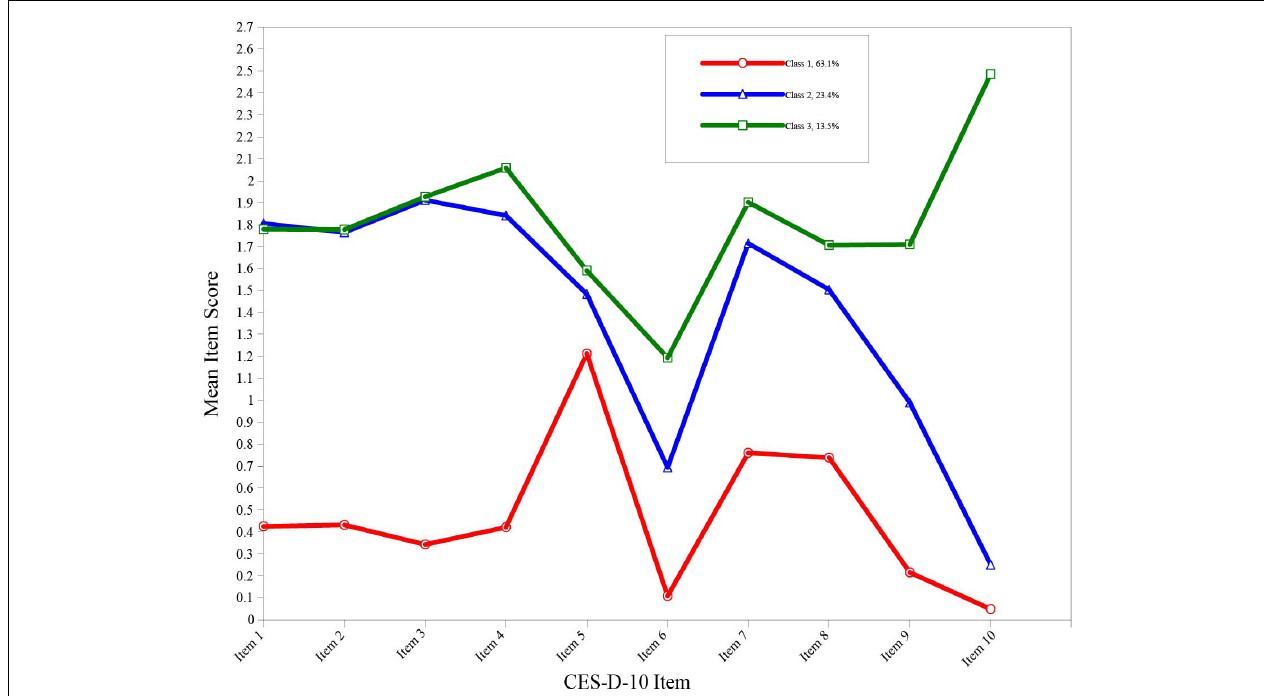
FIGURE 1 | Scree plot of aBIC from LPA analysis. aBIC, adjusted Bayesian information criterion; LPA, latent profile analysis.